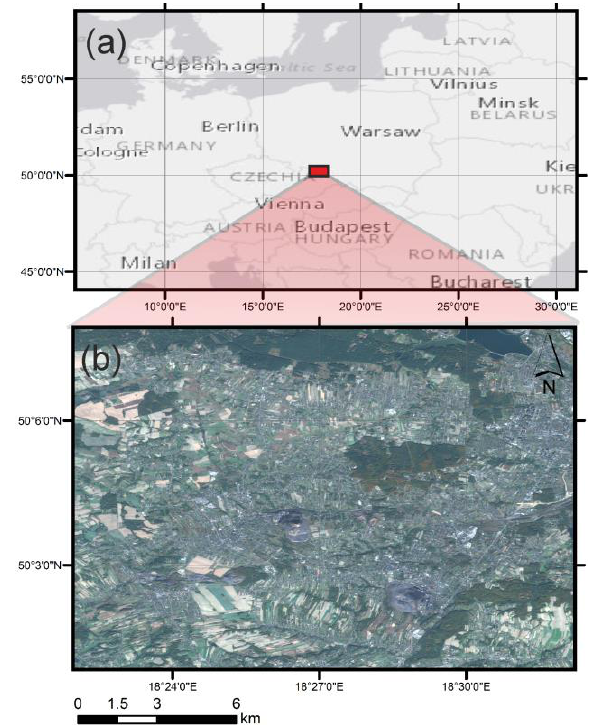
Figure 1. Location of the study area on the Europe country map (a) and Sentinel-2 image of the study area